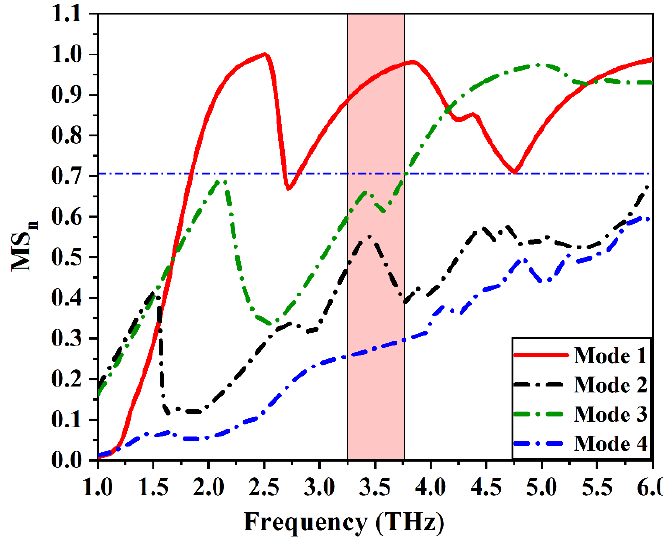
Figure 17. Model significant of Ant. C with the MTM unit cell.